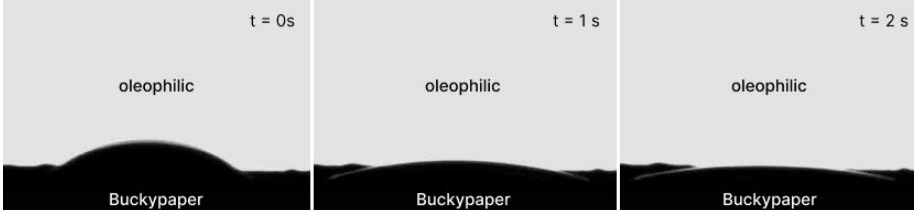
Figure 8. Photographic images of the absorption of an oil drop placed on top of a BP after plasma treatment for 10 minutes.